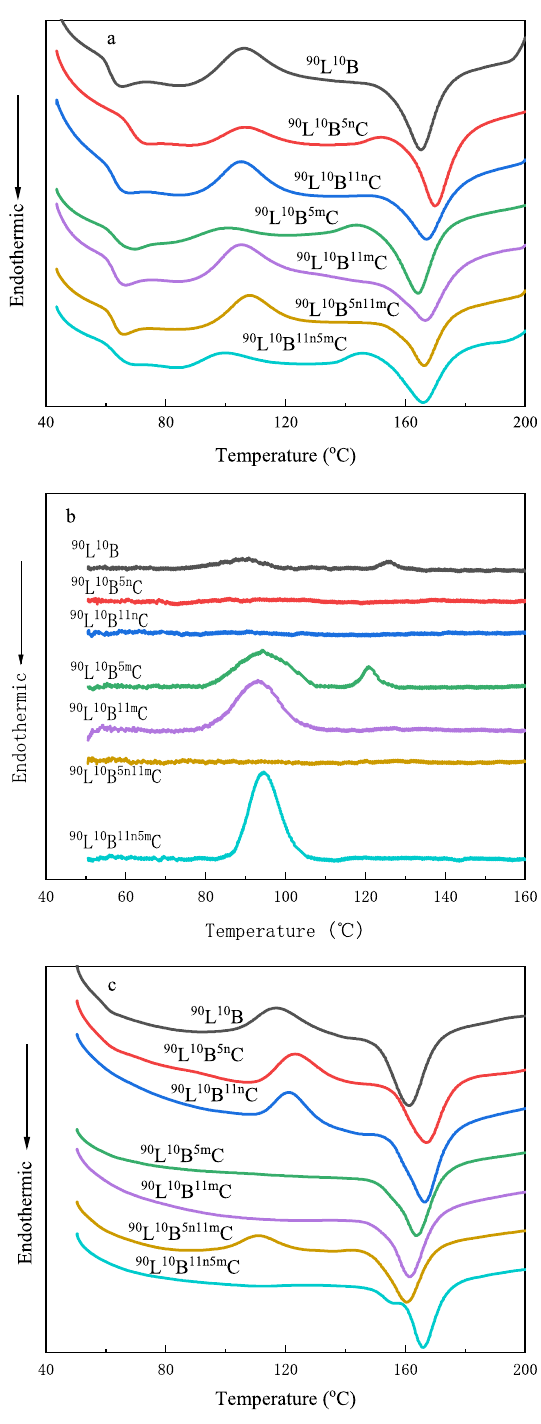
Figure 1: DSC scans of PLA/PBAT blend and PLA/PBAT/CaCO 3 com - posites for both heating and cooling at 20°C · min − 1 : ( a ) the fi rst heating, ( b ) cooling, and ( c ) the second